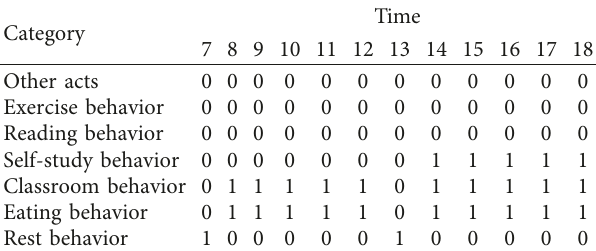
Table 6: Analysis of students’ daily behavioral habits.